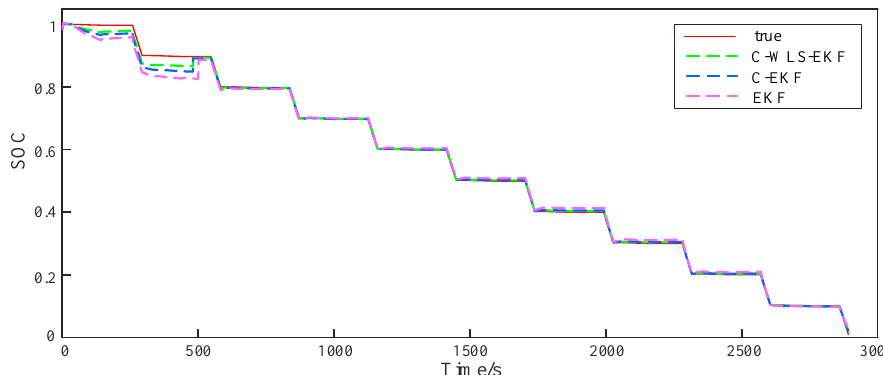
Figure 9. SOC comparison of different algorithm estimation results when the initial value of SOC = 1.